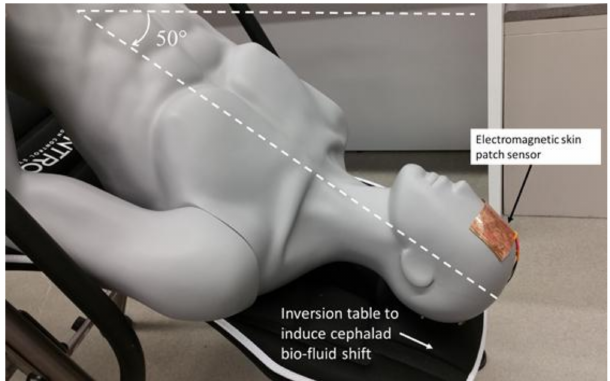
Figure 3. (Live human subjects were used—the mannequin provides visual representation only). The electromagnetic skin patch sensor to detect bio-fluid shift in 50 ◦ head down tilt. The mannequin was used to represent system set-up and sensor placement; however, data was collected from human